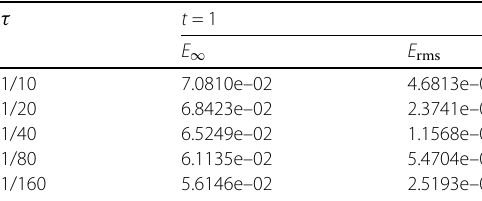
Table 8 Error norms of Example 5.5 at J = 3 τ t =